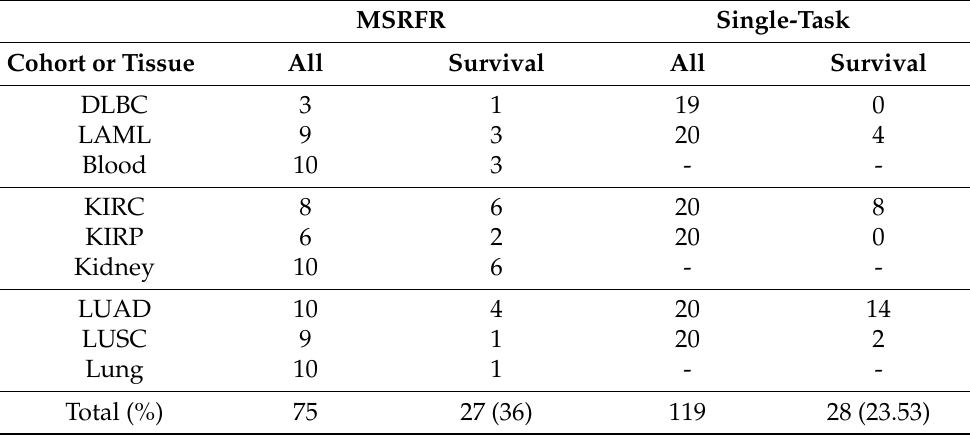
Table 3. Number of identified regulatory modules and regulatory modules with significant survival differences, found by MSRFR and single-task algorithm for cohorts incorporated in this